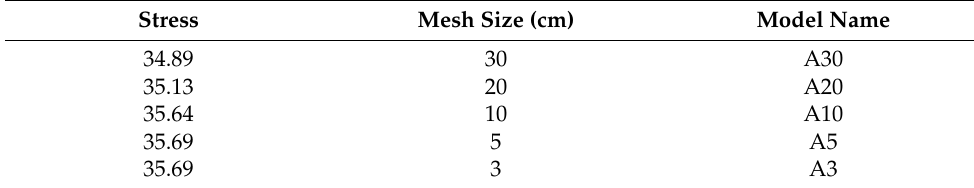
Table 2. The examined mesh sizes from 30 cm to 3 cm.